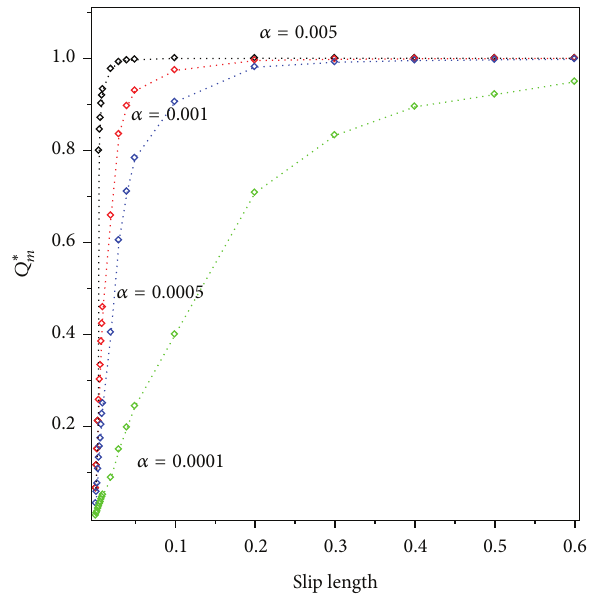
Figure 9: Influence of slip length on the amplitude of the flow rate 𝑄 ∗ 𝑚 on the cross-section of the channel with the area of and ratio 𝑏/𝑎 of 1 under different frequencies 𝜔 = 𝛼/𝜌𝑎 2 with different 𝛼 .